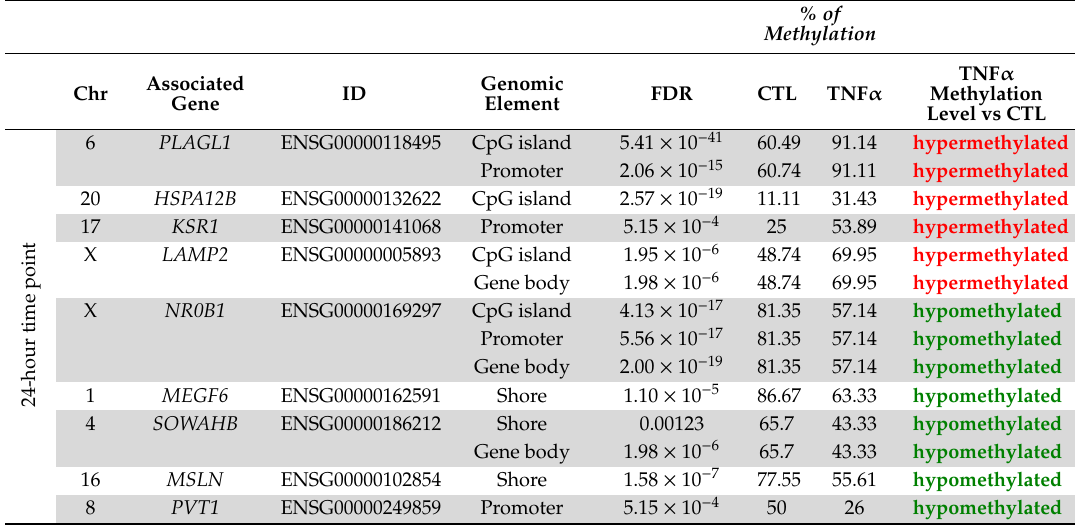
Table 1. List of genes proximal to significant DMRs with a minimum di ff erence of 20%.